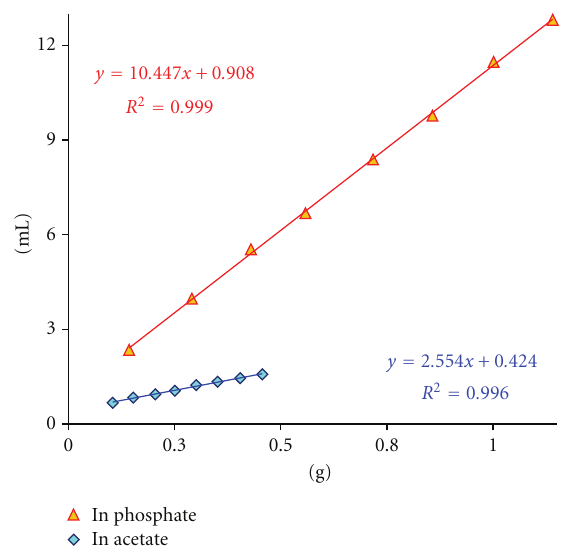
Figure 1: Graphical evaluation of alkali consumption of HCl-titra- tion in Na 2 HPO 4 solution.